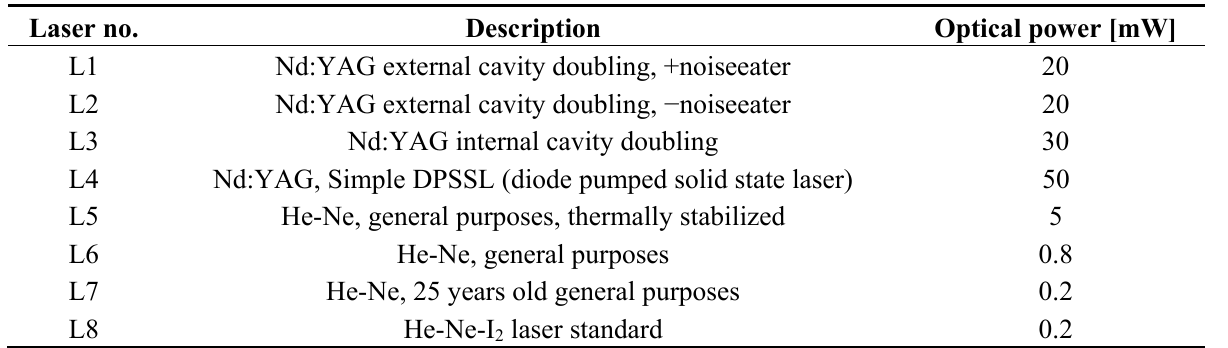
Table 3. A list of tested laser